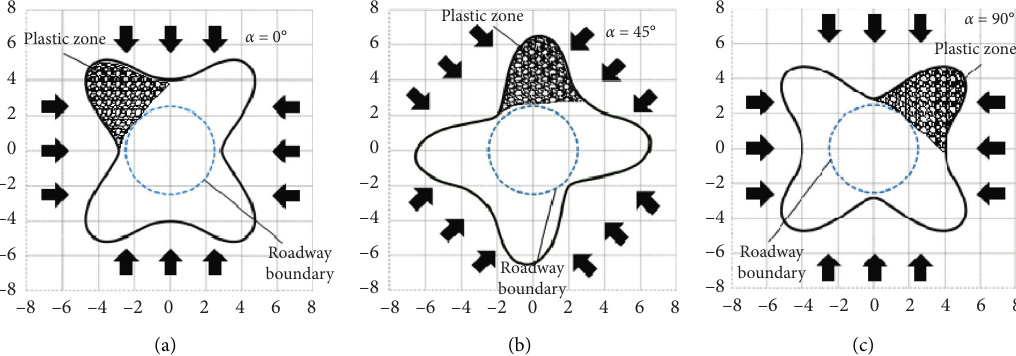
Figure 5: Morphology distribution of the roadway plastic zone influenced by the change of the principal stress direction.